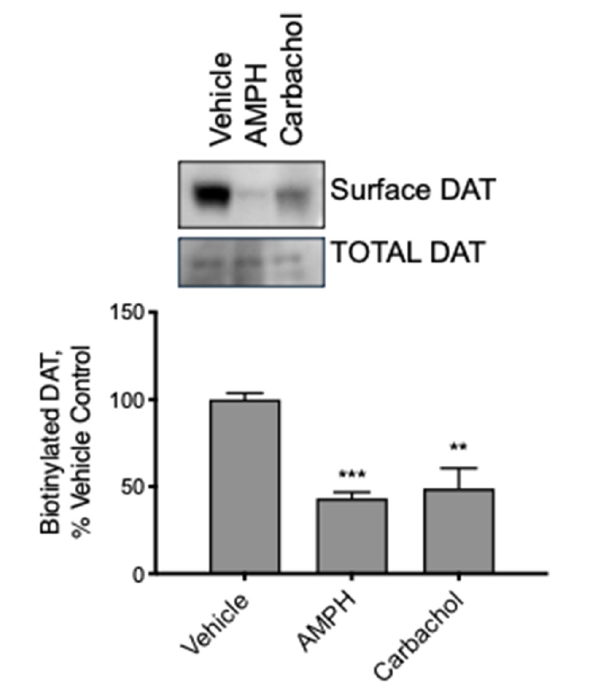
FIGURE 6 | DAT internalizes in response to AMPH and carbachol in acute brain slices from adult mice. We exposed slices from mature mouse brain to vehicle, AMPH or carbachol for 30 min and then biotinylated all the surface proteins, isolated the biotinylated proteins, and assessed DAT localization by Western blot. Carbachol (30 µ M) as well as AMPH (10 µ M), as well as AMPH (10 M), decreased the amount of biotinylated, membrane membrane-localized DAT ( n = 3, ** P ≤ 0.01 and *** P ≤ 0.001 by one-way